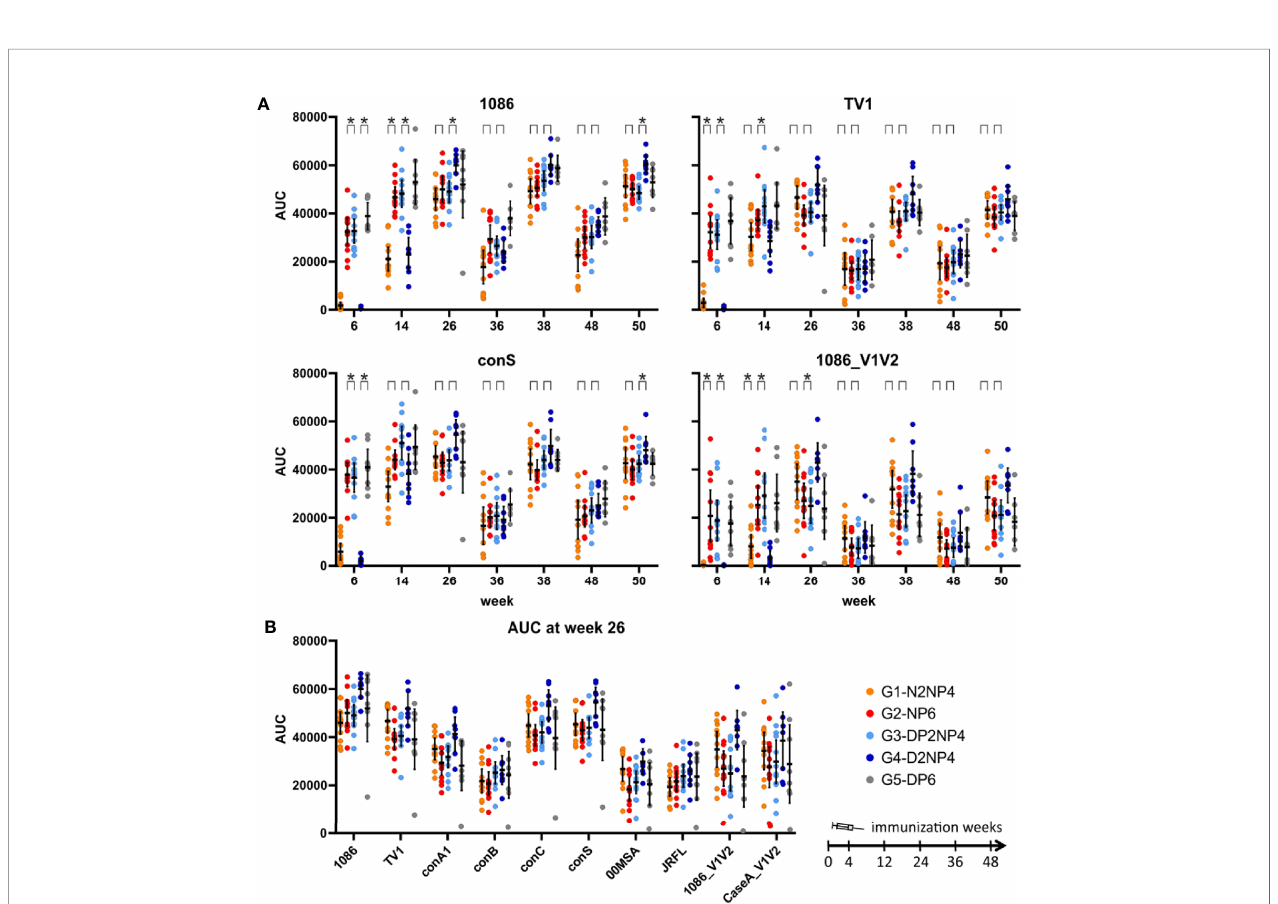
FIGURE 6 | Binding antibody multiplex assay of IgG in plasma samples. (A) Time-courses for IgG responses (AUC values) towards selected readout antigens. Responses of individual monkeys are shown as colored dots and median and interquartile ranges are shown as black lines. Differences between groups 1 and 2, as well as between groups 3 and 4, were formally statistically tested; asterisks denote signi fi cant differences with p <0.05 (Wilcoxon rank sum test, Bonferroni-corrected for each antigen panel). (B) Comparison of week 26 responses (AUC values) towards the readout